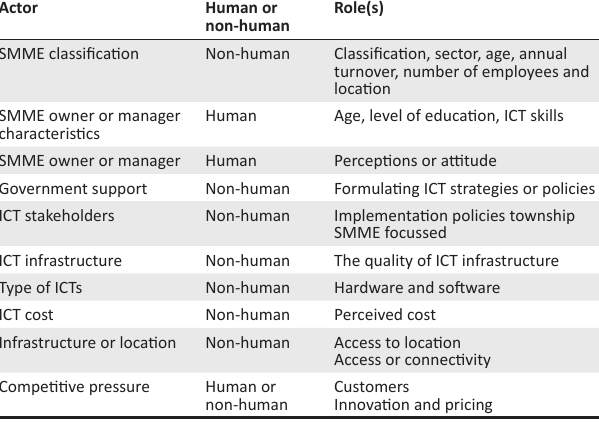
TABLE 2: Actors within the township network and illustration of their